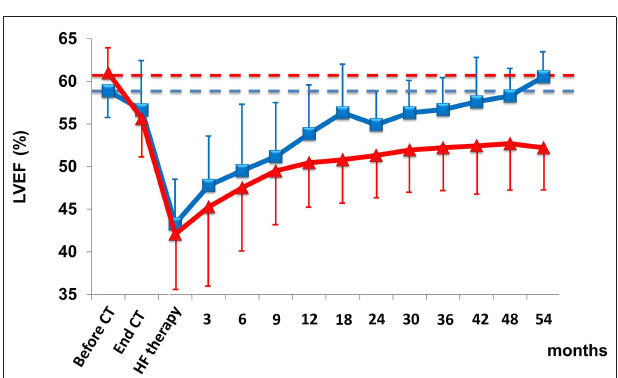
FIGURE 3 | LVEF in patients with cardiotoxicity and with partial (triangle) or full (square) recovery with heart failure therapy. Data are mean ± SD. CT, chemotherapy; HF, heart failure. From Cardinale et al.